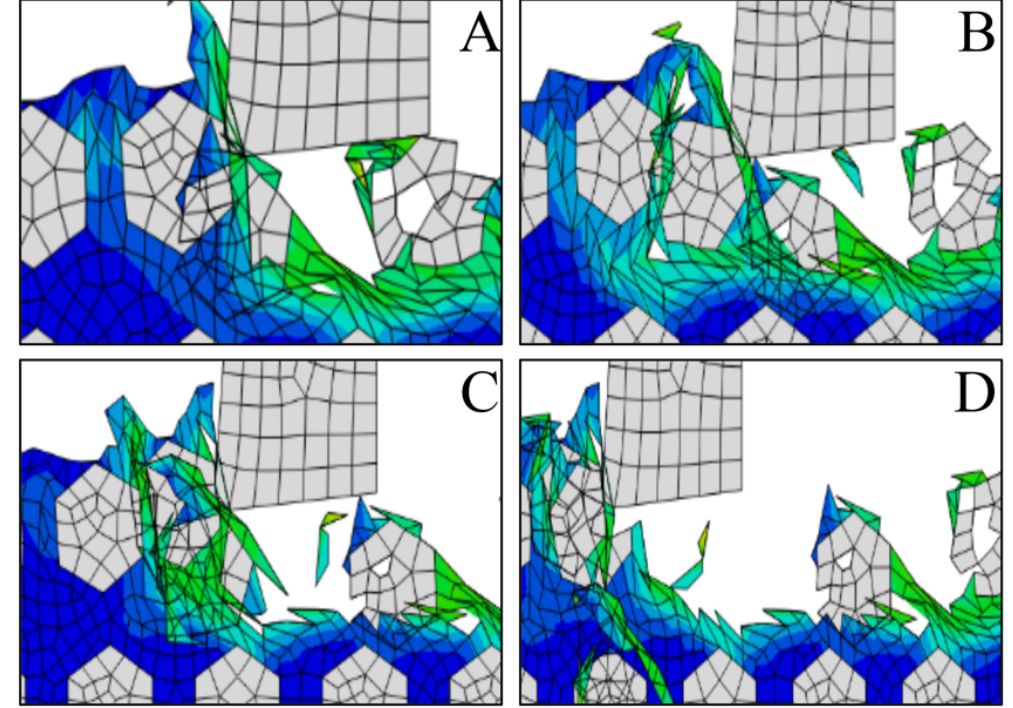
Figure 20. ( A – D ) Schematic diagram of the shallow pit formation process.